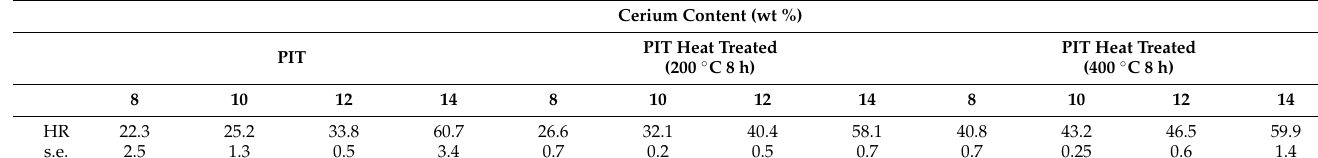
Table 2. Rockwell hardness (HR 15TS) elemental Al-xCe PIT before and after heat treatment.